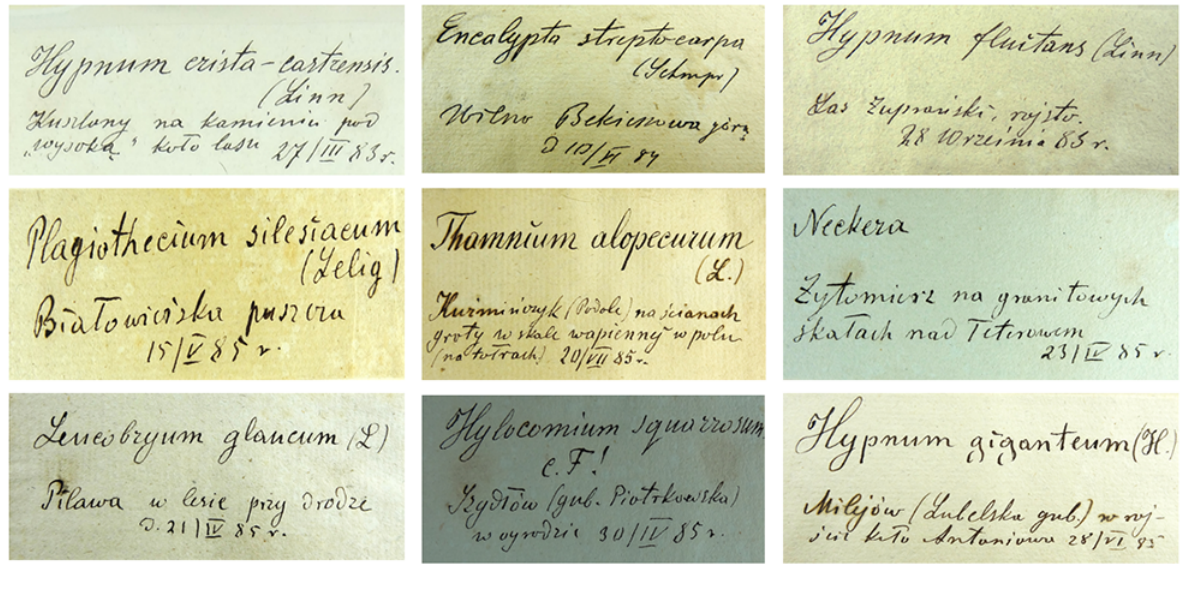
Figure 4 e labels of the specimens from the bryophyte collection of K.